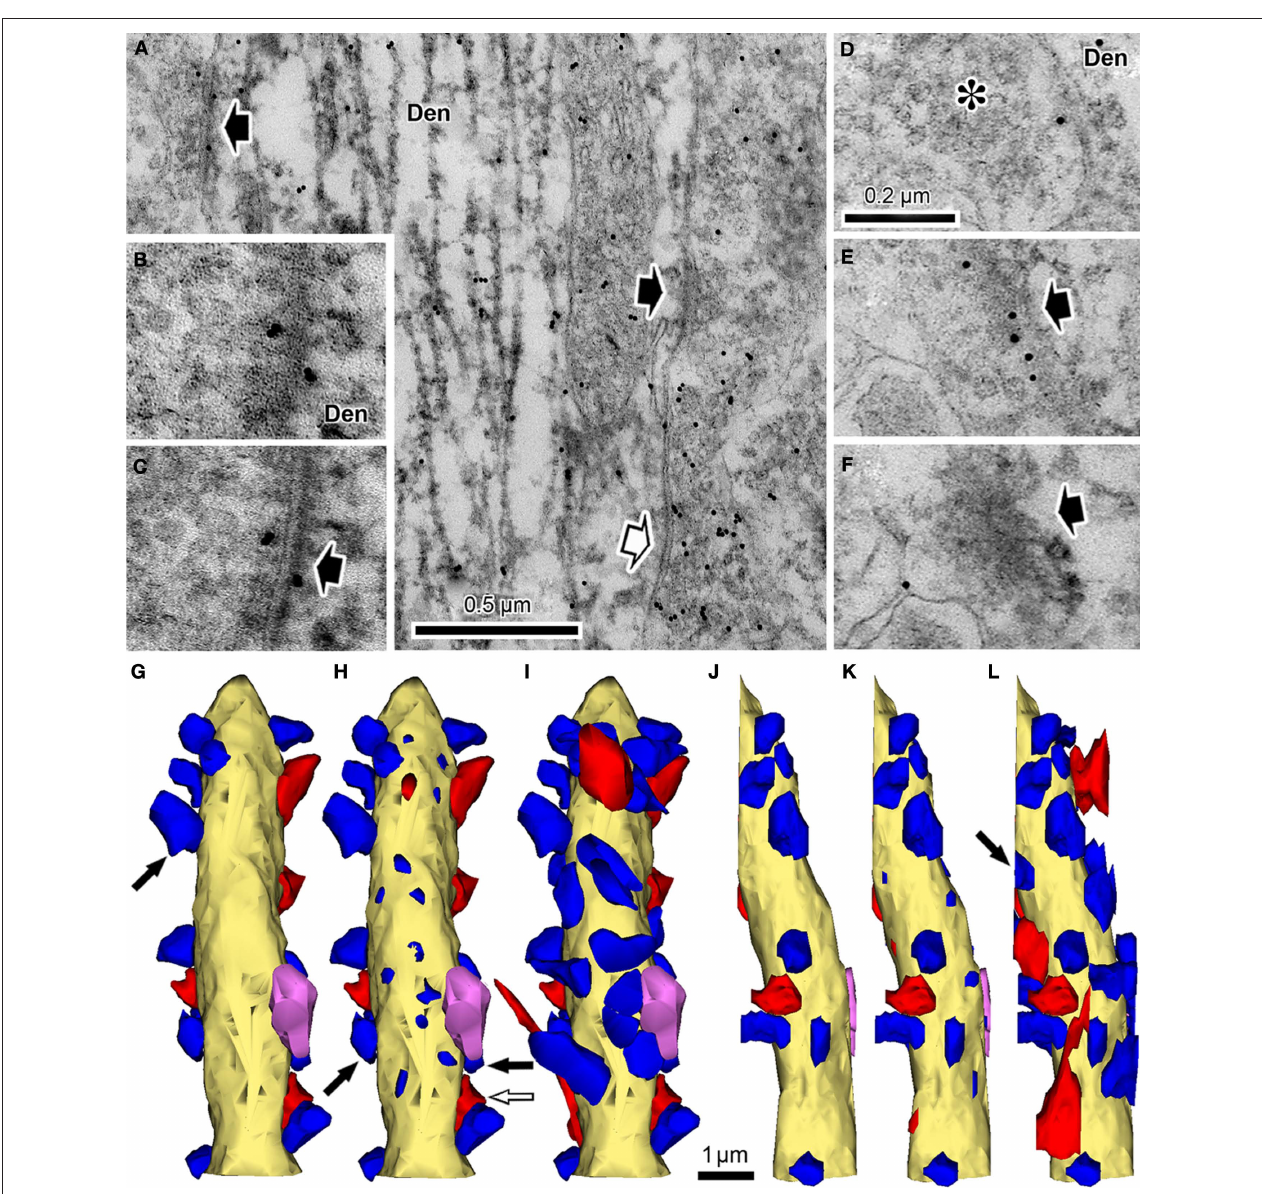
FIGURE 2 | Synaptic contact identifi cation on parvalbumin-positive dendrites together with GABA post-embedding staining. (A) This dendrite (Den) is labeled with nickel-DAB precipitate for pre-embedding parvalbumin immunoreaction and colloidal gold for post-embedding GABA immunoreaction. A GABA-positive bouton makes a symmetrical synaptic contact (white arrow) and two GABA-negative boutons make asymmetrical contacts onto the parvalbumin-positive dendrite. The cleft plane of these synaptic contacts is vertically angled to the plane of section, so the cleft is clearly observed. (B) GABA-negative synaptic contact with the cleft, cut diagonally on the parvalbumin positive dendrite (Den). The cleft is not clearly observed. (C) The section was tilted about 30 ° in order to see the cleft clearly (arrow). (D–F) A GABA-negative bouton makes synaptic contact with the cleft occurring at a steep angle to the plane of section, identifi ed in the successive serial sections. In the fi rst section, a presynaptic bouton with many synaptic vesicles ( D , asterisk) is found next to a parvalbumin positive dendrite (Den). The next section contains a few vesicles and a small number of electron dense objects, most likely indicative of a PSD ( E , arrow). The third section shows the PSD spreading